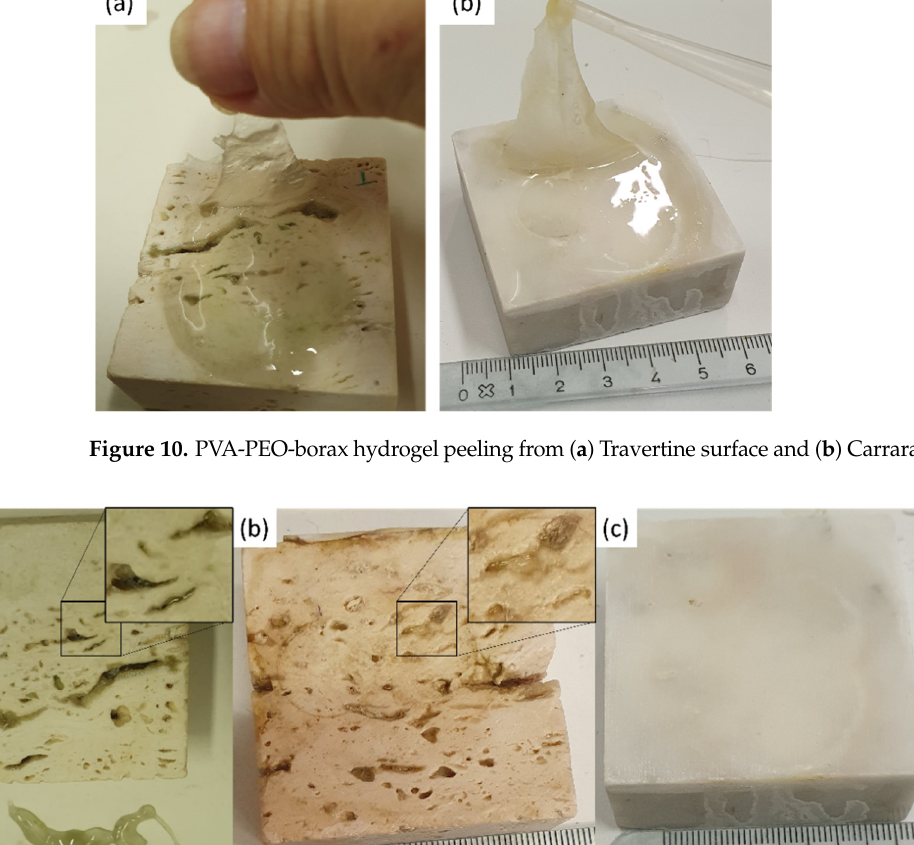
15 of 19 Figure 9. In ( a , b ) Travertine sample stained by corrosion products of one penny reacting with citric acid; the greenish-black stain on Travertine produced by reaction of two euro cents with citric acid in ( c ); in ( d ) Carrara marble surface with acidic corrosion of four euro cents with citric acid. The coins and the reagent (i.e., citric acid) were left on the stones surface for one week. After that, the coins were removed from the stones surface and a greenish-black stain was